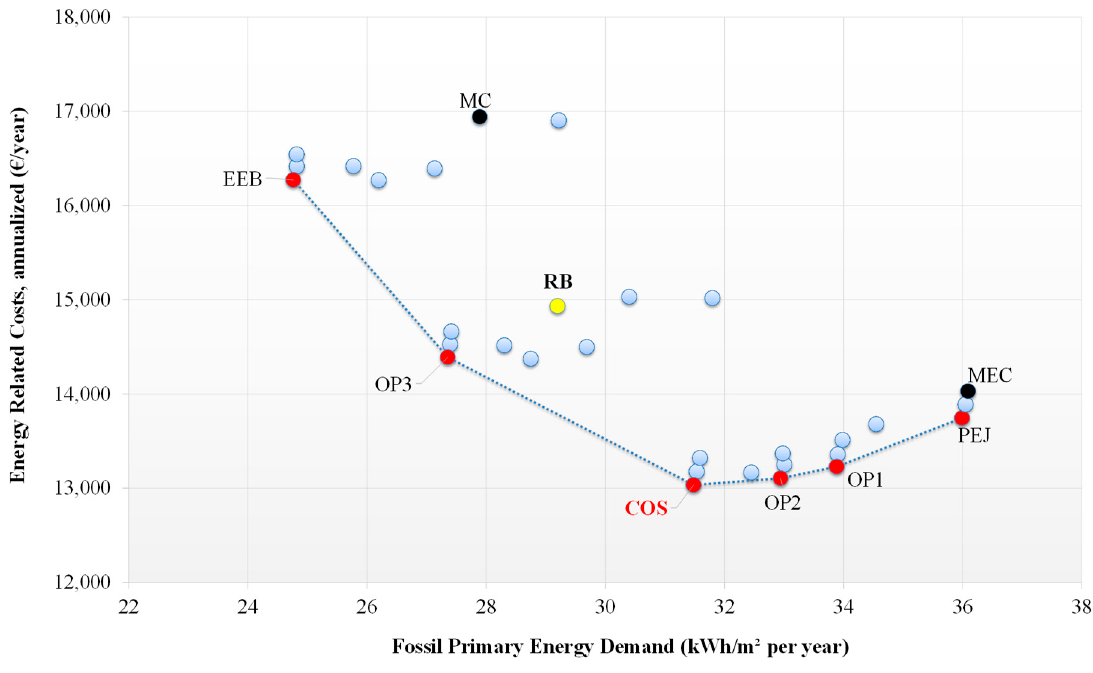
Figure 3. Annualized energy-related costs plotted against primary energy demands for the more representative EEMs analyzed for the warmer climatic zone B, including a financial projection. Table 10. Detected optimal constructive solutions concerning different energy efficiency measures (EEMs) for climatic zone B (VWT, insulation thickness in vertical wall; GST, insulation thickness in the ground slab; SFT, insulation thickness in the second last floor; GS, glazing system).